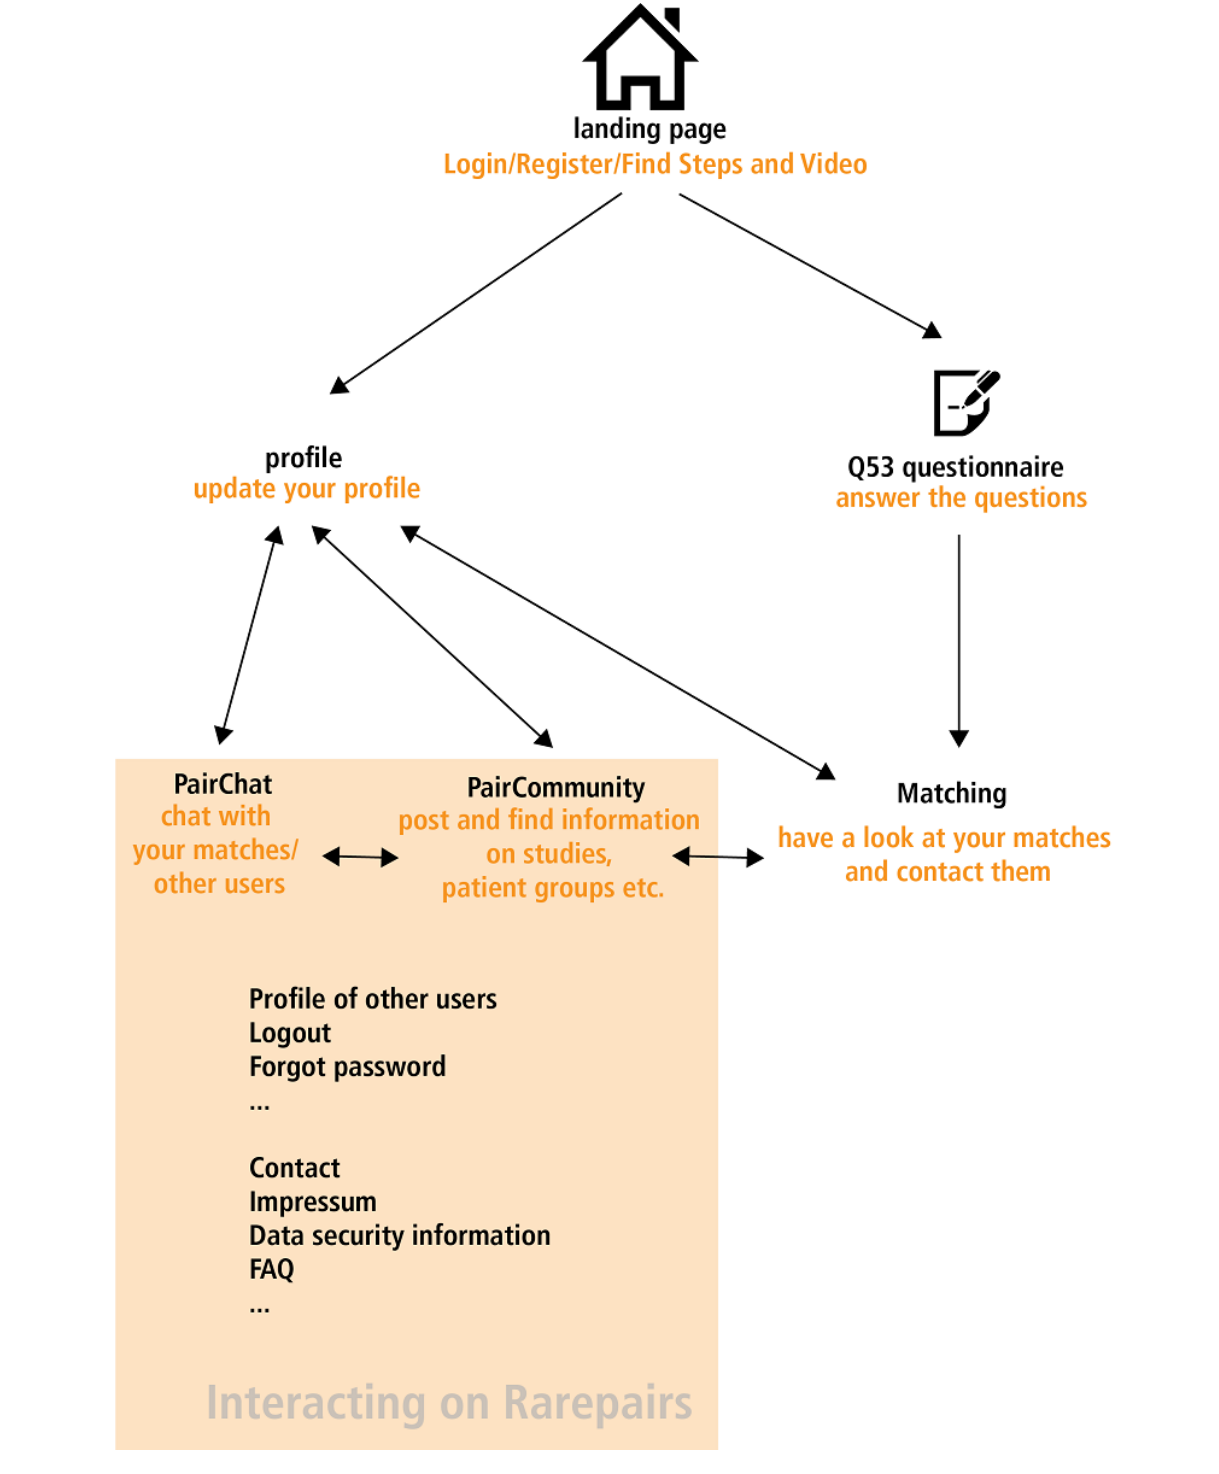
Figure 2. Simplified scheme of the clicking path for new and already registered users of